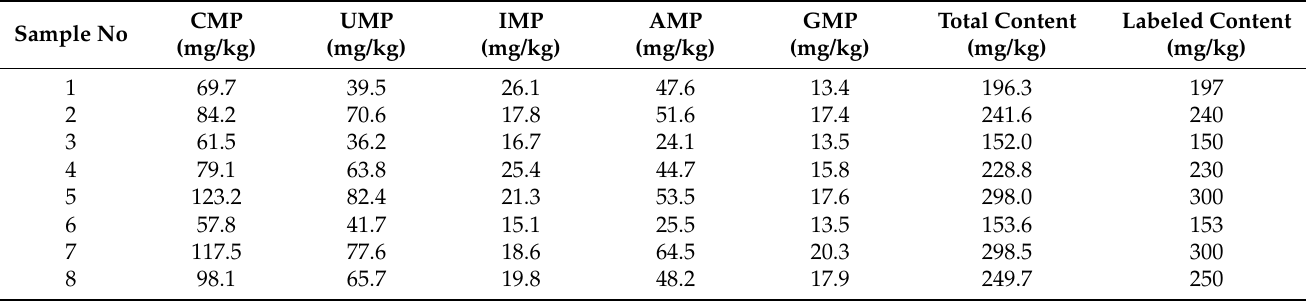
Table 2. Contents of five nucleotides in real